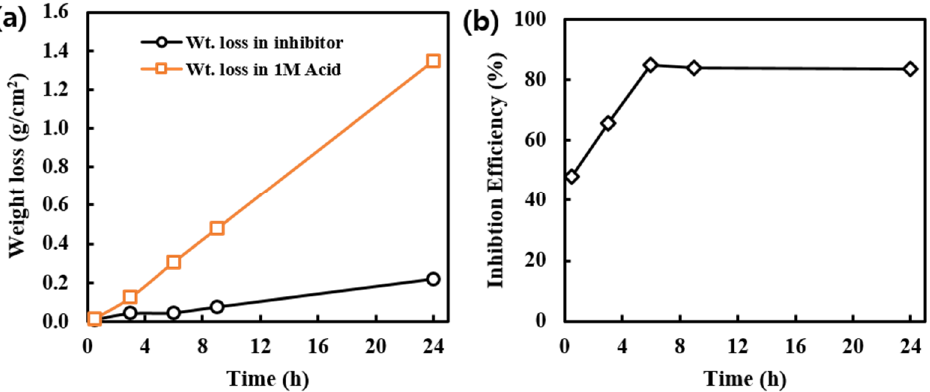
Figure 4. ( a ) Variation of weight loss of MS samples in acid and inhibitor solution at fixed intervals of time and ( b ) Inhibition efficiency of alkaloid solution at different intervals of time.